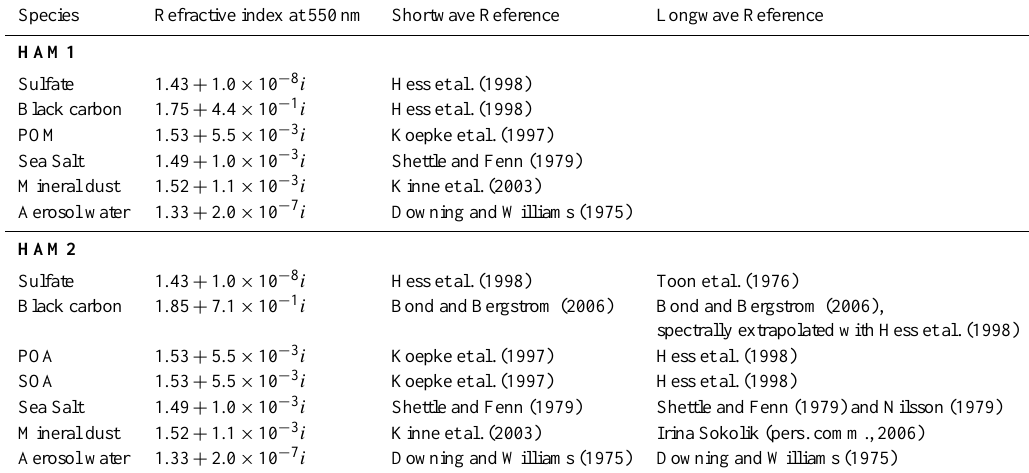
Table 3. References for the shortwave and longwave refractive indices for each aerosol composition in the HAM model. For the shortwave part, the refractive index at 550nm wavelength is listed, in which i denotes the imaginary unit. After Stier et al. (2005), Stier et al. (2007), and O’Donnell et al.